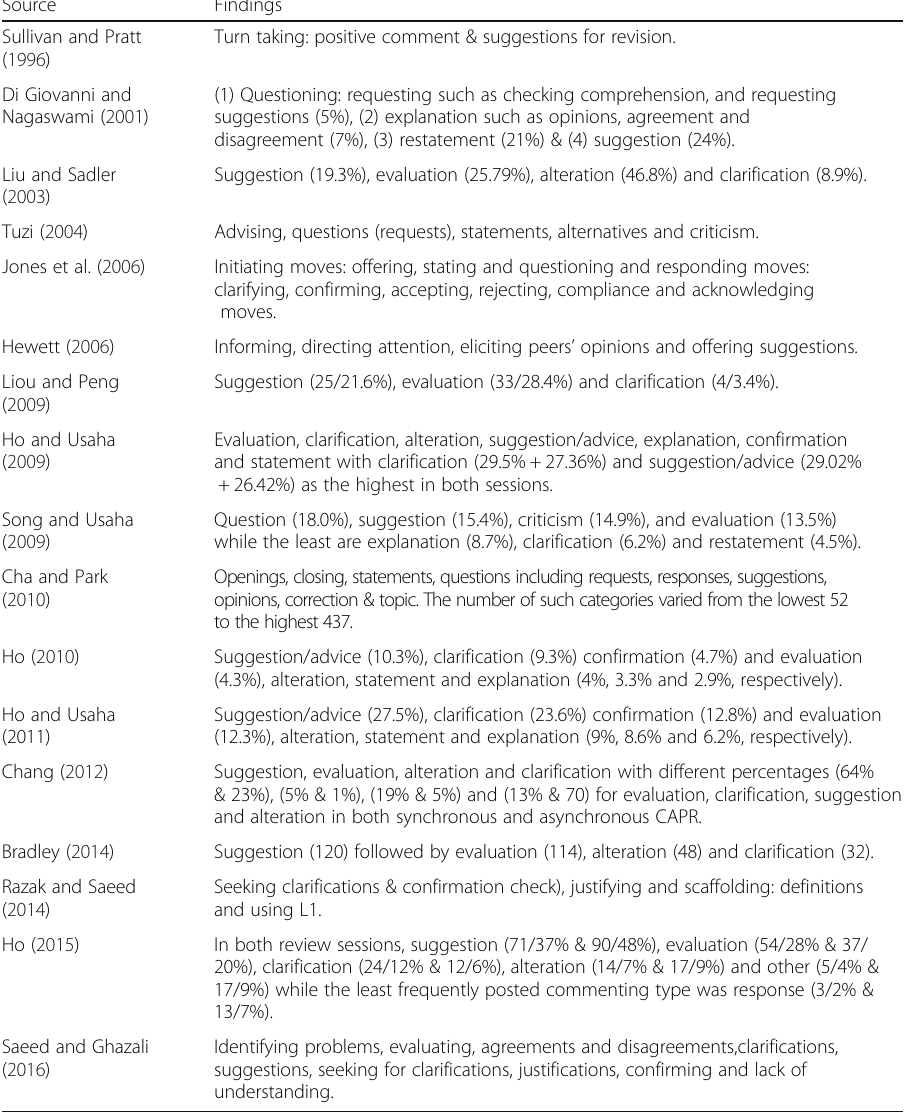
Table 2 A Summary of the Patterns of Exploratory Feedback Exchanges in CAPR Source Findings Sullivan and Pratt